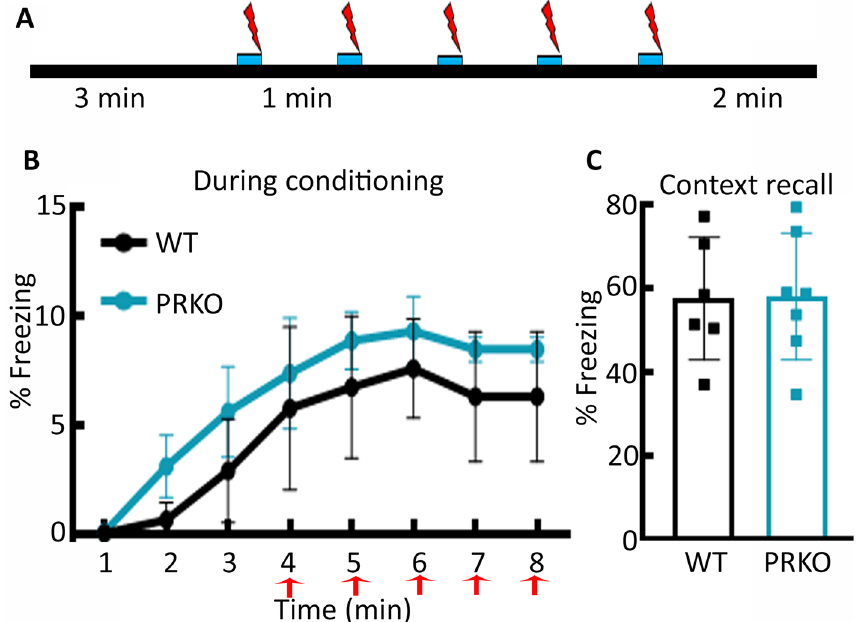
Figure 7. The cued-contextual fear conditioning in PRKO male mice. ( A ) A schematic showing fear conditioning and recall. Following an initial 3 min of chamber exploration, the animals received five 2-s footshocks that were contiguous with a 20-s tone. The animals were removed from the chamber two min after the last footshock. ( B ) Percent freezing in the WT and PRKO male mice following the five footshocks, n = 6 WT and 7 PRKO. ( C ) Percent freezing during the context recall was performed 24 h later. The number of replicates is the same as in